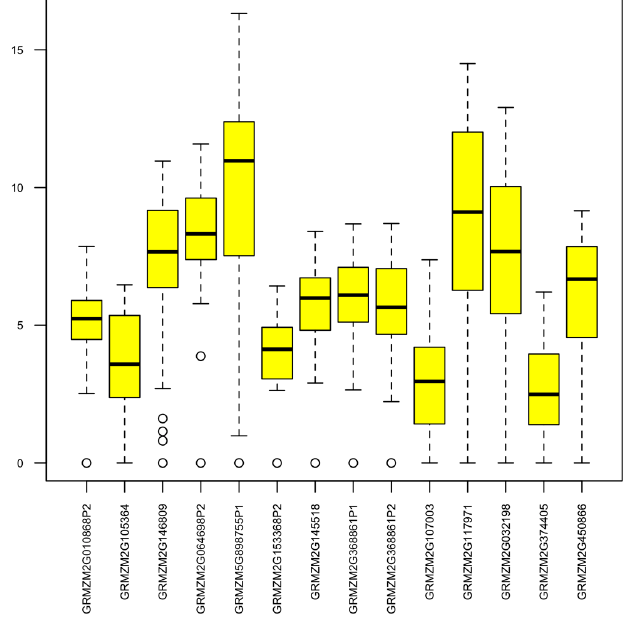
Figure 3. A boxplot showing the statistical summary of the range of relative gene expression levels of selected maize AMP genes across all 10 maize inbred lines.